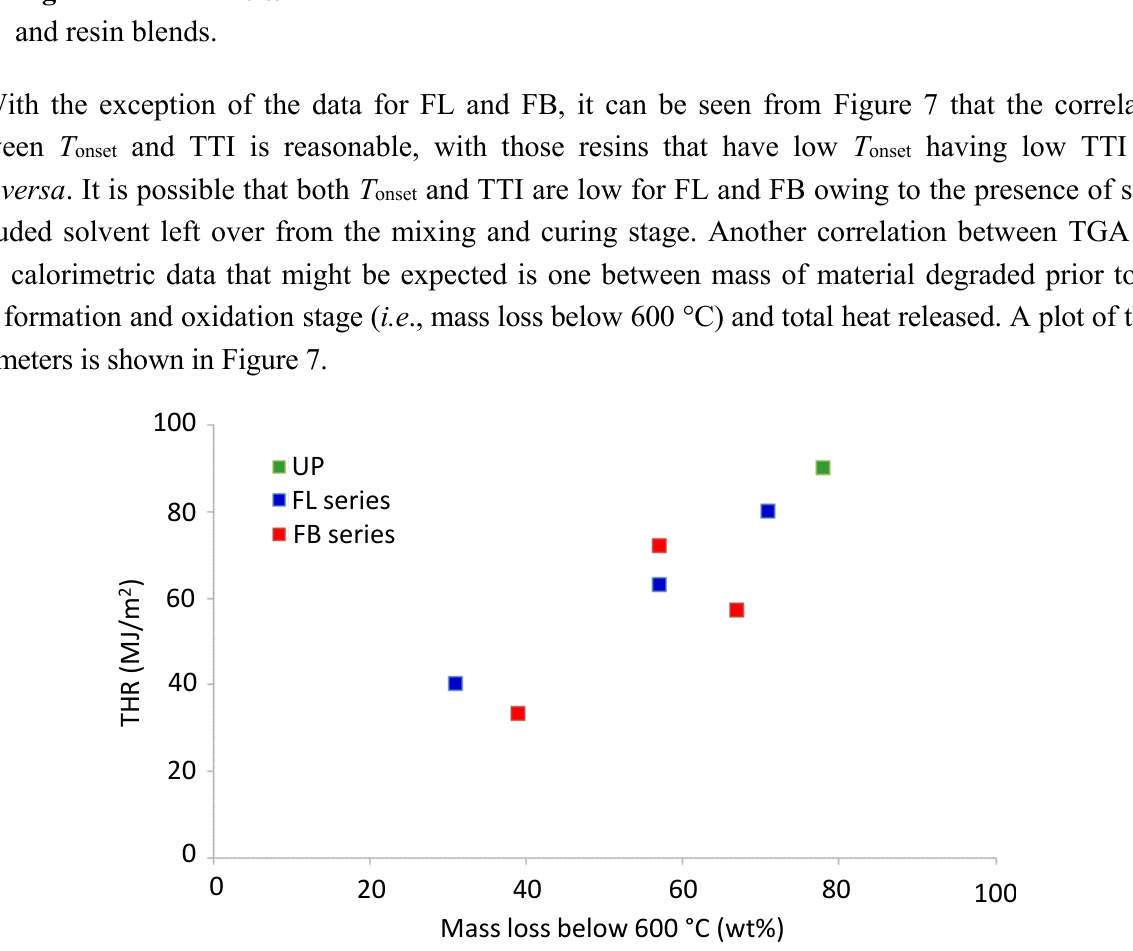
Figure 7. THR vs . mass loss below 600 °C for cured resins and resin